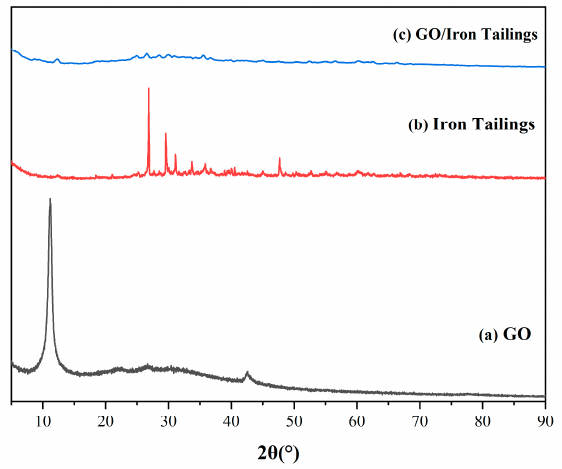
Figure 2. XRD image of GO ( a ), iron tailings ( b ), GO/iron tailings ( c ).